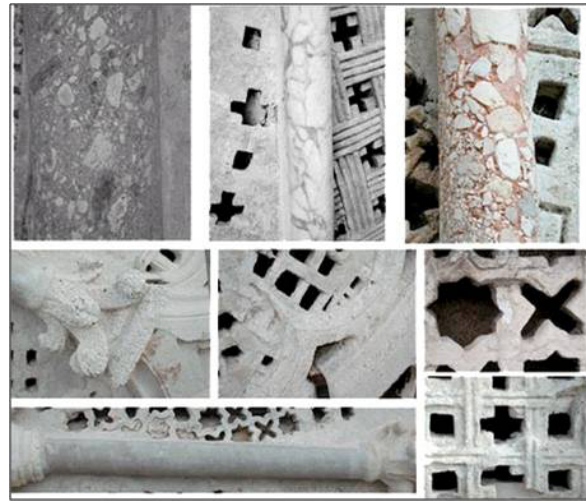
Fig. 2. Examples of building materials used for columns (grey breccia, Pavonazzetto marble, Breccia Corallina and green-grey sandstone), capitals (medium-fine grained calcarenites), arched rib- works and triangular carved panels (medium to coarse grained